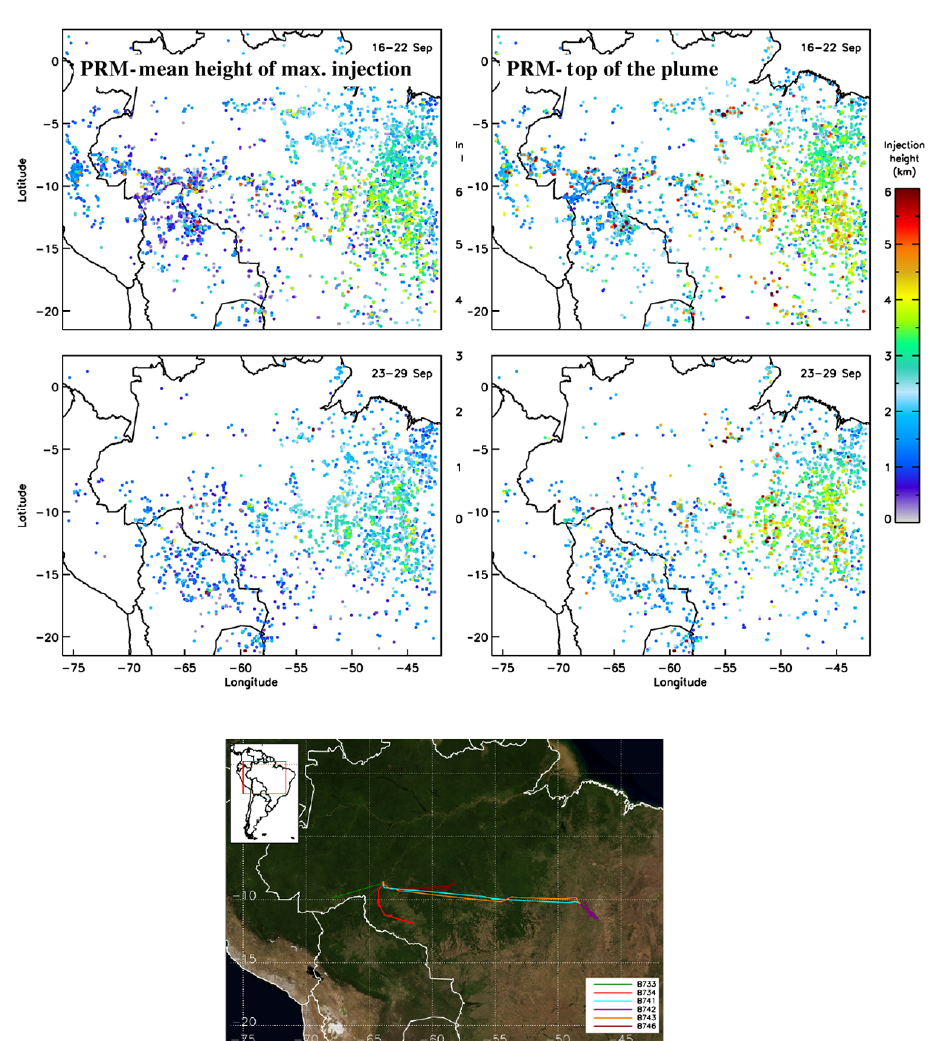
Figure 9. Left: PRM mean height of maximum injection from GFAS, accumulated values from (top) 16 to 22 September 2012 and (middle) 23 to 29 September 2012. Right: PRM top of the plume from GFAS, accumulated values from (top) 16 to 22 September 2012 and (middle) 23 to 29 September 2012. Bottom: ground tracks of the six research flights of the SAMBBA field